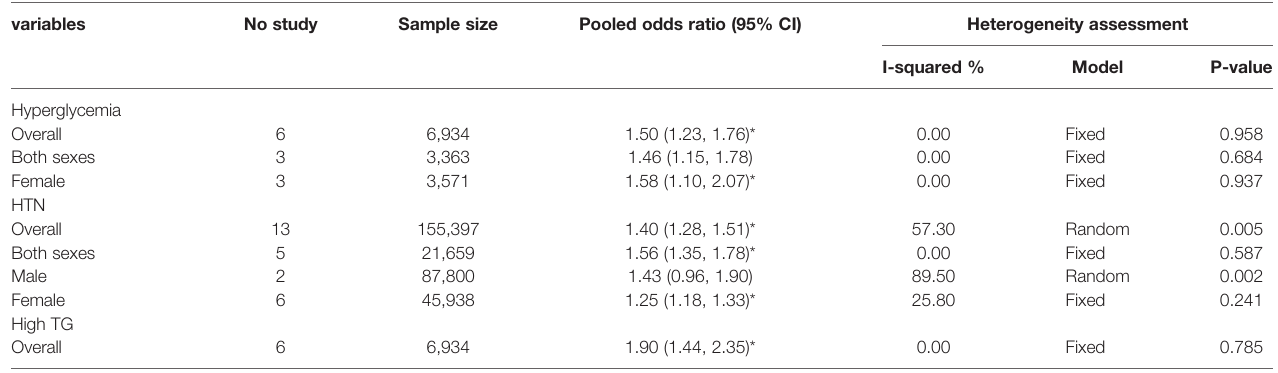
TABLE 4 | Strati fi ed meta-analysis of association between NWO with CMRFs according to sex.